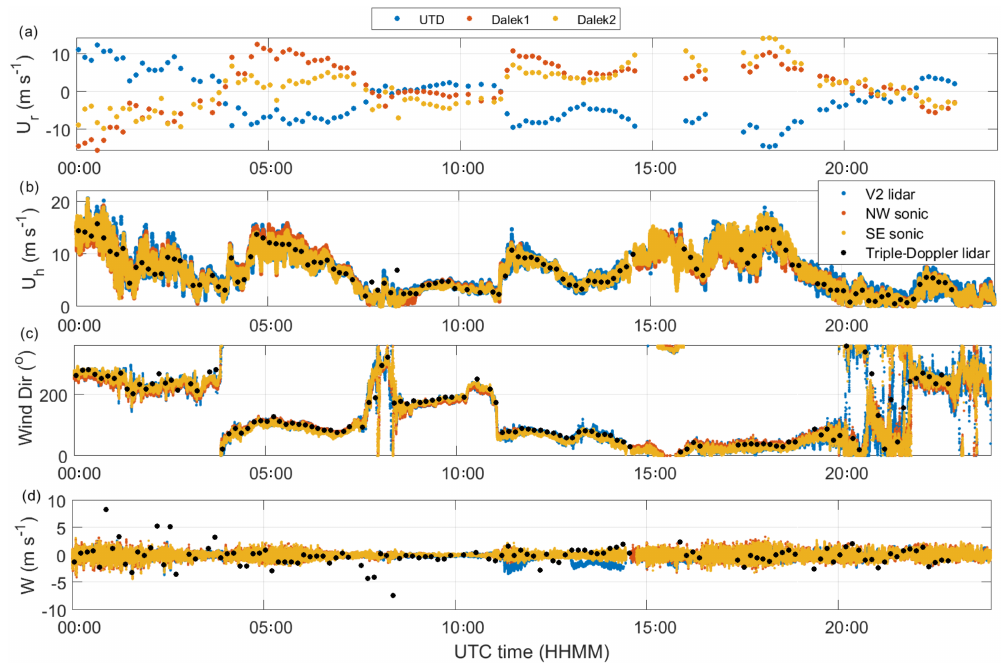
Figure 7. Triple-Doppler lidar measurements at 100m height and assessment against sonic anemometer and lidar profiler data: (a) line- of-sight velocities from the three scanning lidars; (b) horizontal wind speed U h (ms − 1 ) ; (c) wind direction ( ◦ ); (d) vertical velocity W (ms − 1 )